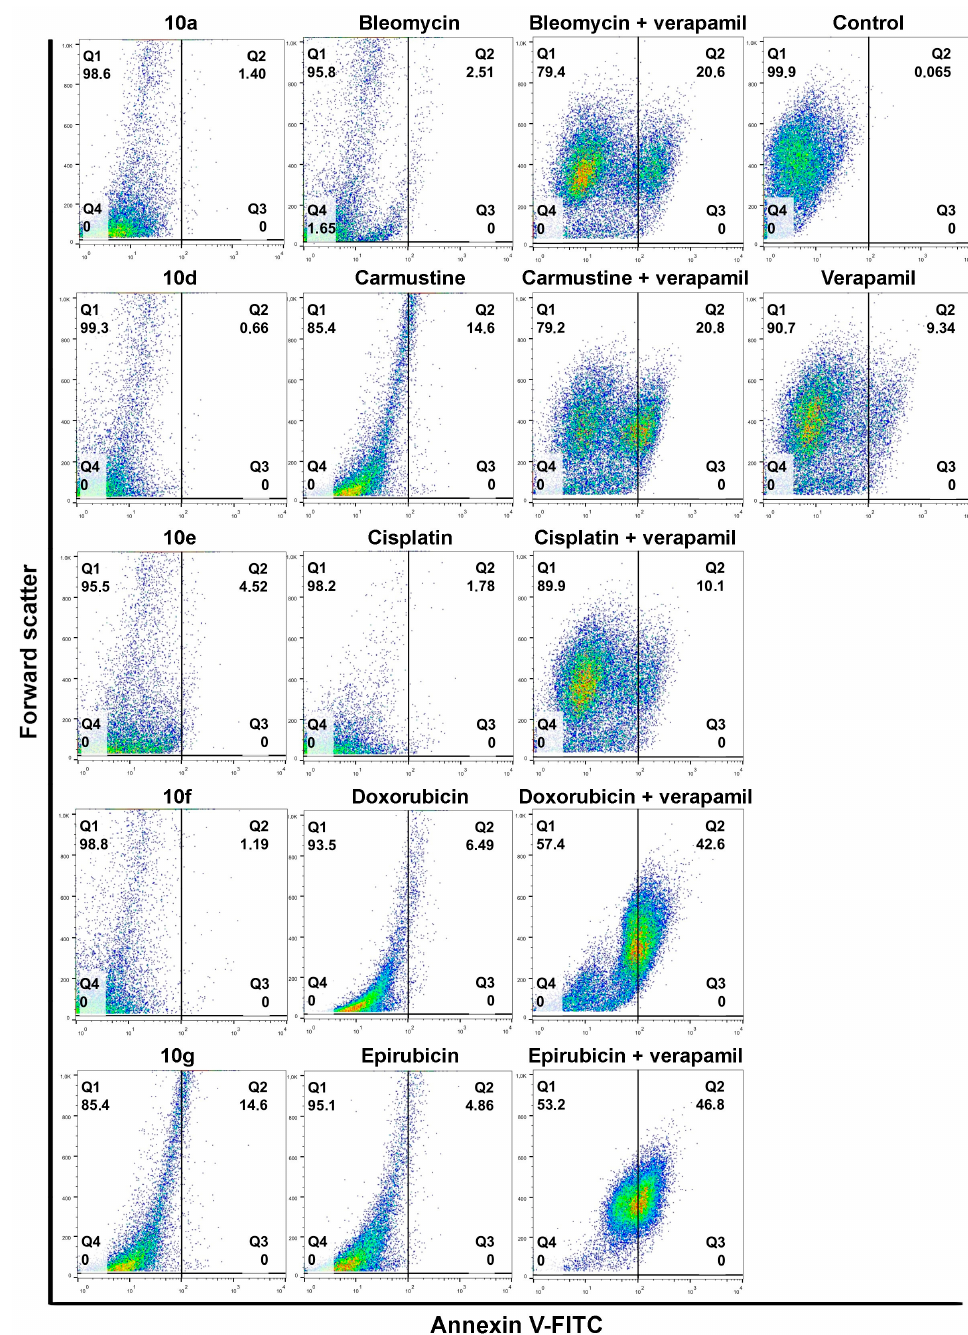
Figure 4. The degree of apoptosis induction in multidrug-resistant Colo 320 cells upon exposure to androstano-arylpyrimidines or various chemotherapy drugs. Annexin V-fluorescein isothiocyanate fluorescence of 10,000 cells/sample was measured with flow cytometry and plotted against forward scatter. Cells were treated either with compound 10a, 10d, 10e, 10f, or 10g alone (in 20 µ M concentra- tion for 24 h) or with chemotherapy drugs alone (Bleomycin, Carmustine, Cisplatin, Doxorubicin or Epirubicin at various concentrations, please refer to Materials and methods and Supplementary Material Table S2) for 24 h. Apoptosis induction was assessed upon Verapamil (in 4 µ M for 24 h) as well as following Verapamil and chemotherapy drug combination treatments. The numbers in the Q2 quadrants represent the percentage of Annexin V-positive apoptotic cells. In the color density plots each dot represents a single detected